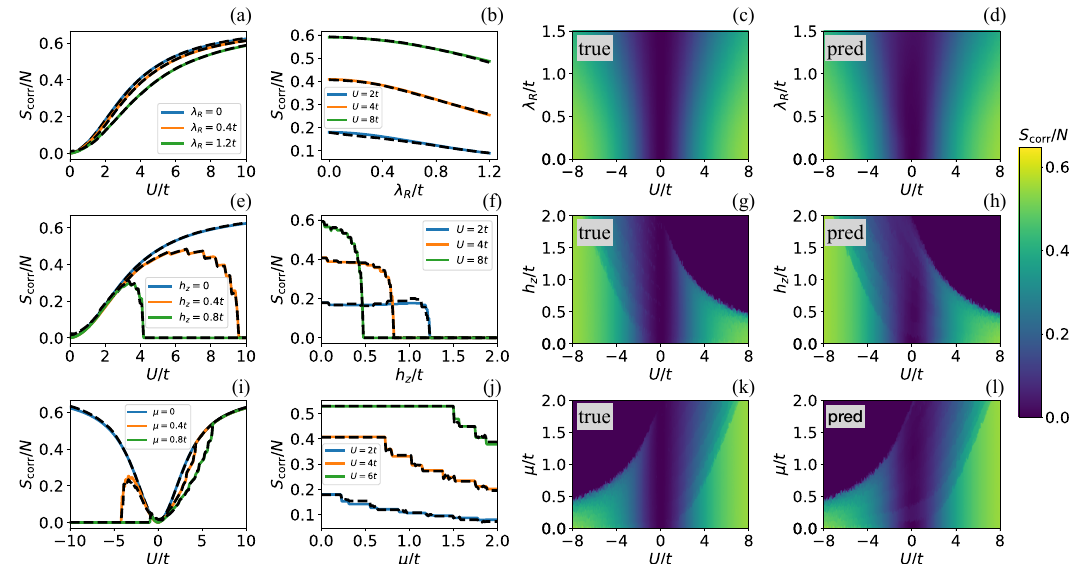
Figure 2: Correlation entropy for the generalized interacting model in the limit V = t ′ = 0. Dashed lines correspond to neural-network prediction and solid lines to the real value of the correlation entropy. Dependence of S tion U for various values of λ values of µ in (i). Dependence of S for various values of U . Panels (c,g,k) show the real correlation entropy and (d,h,l) the neural-network prediction based on local measurements, in the plane λ h U (g,h), and µ U z